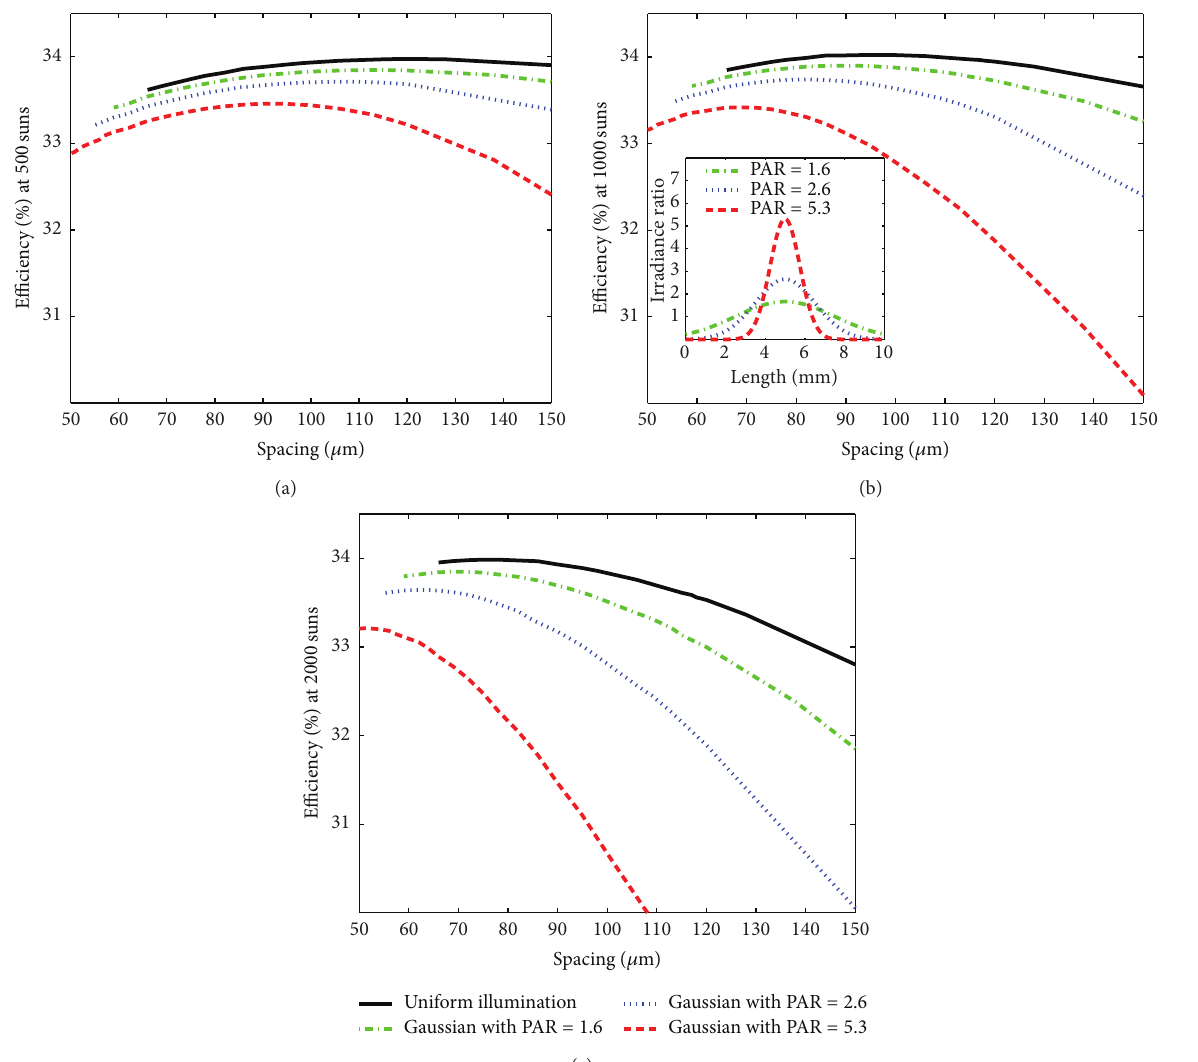
Figure 5: Efficiency as a function of finger spacing at a concentration of (a) 500 suns, (b) 1000 suns, and (c) 2000 suns; inset: Gaussian irradiance distributions with different peak to average ratios (PARs).